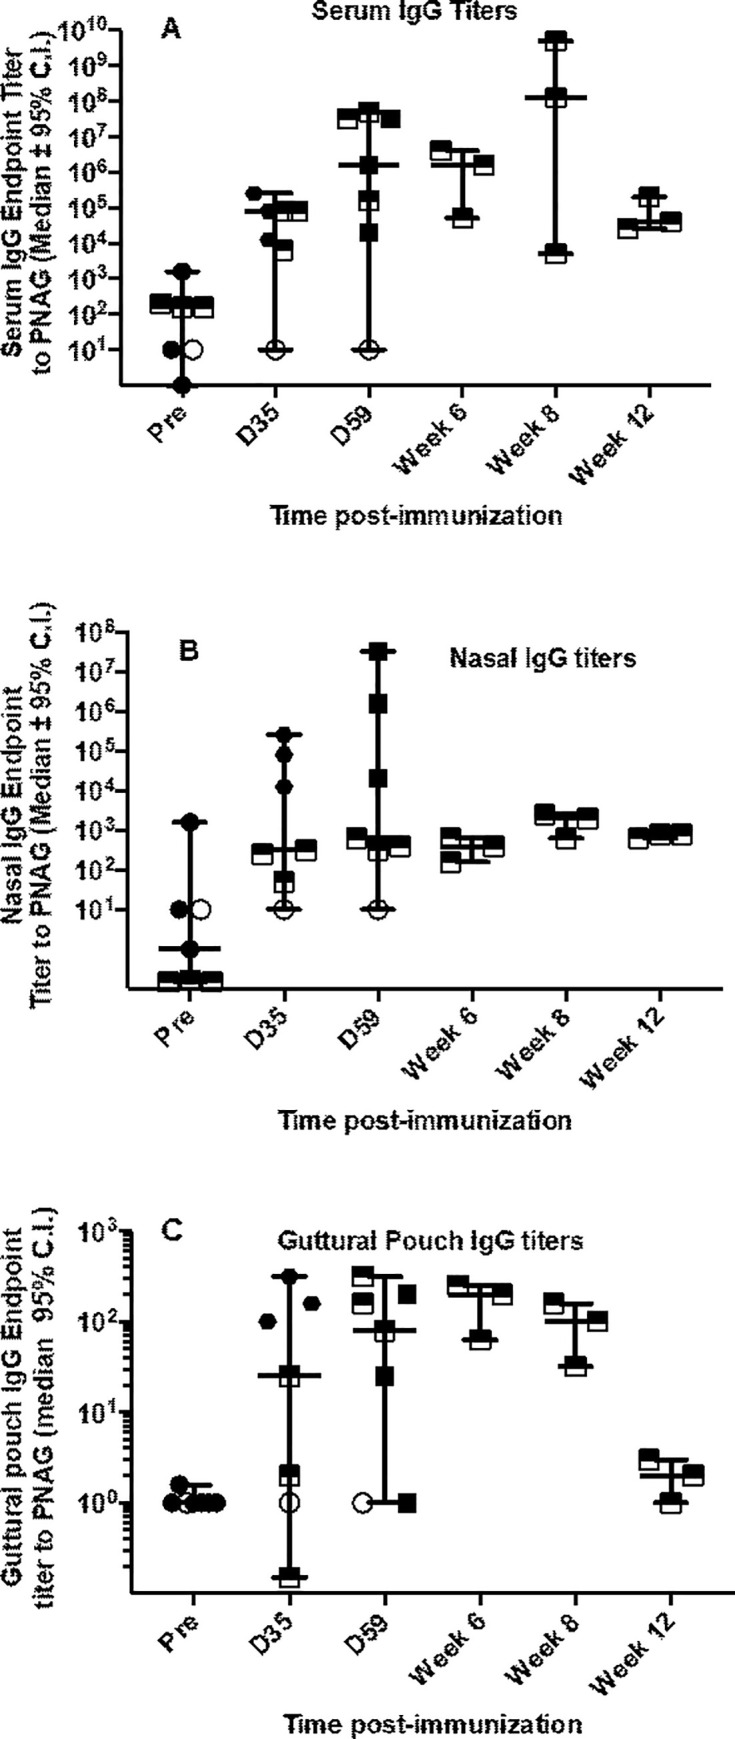
A combination of IM and IN immunization induces IgG titers to PNAG in serum (A), nasal secretions (B), and guttural pouch lavages (C). Symbols represent endpoint titers calculated by liner regression. Open circle is control, non-immunized horse. Filled squares represent titers in immunized but not challenged horses. Half-filled squares represent titers in horses challenged with SEE. Samples were only collected from 4 horses used in the initial immunization study through day 59.